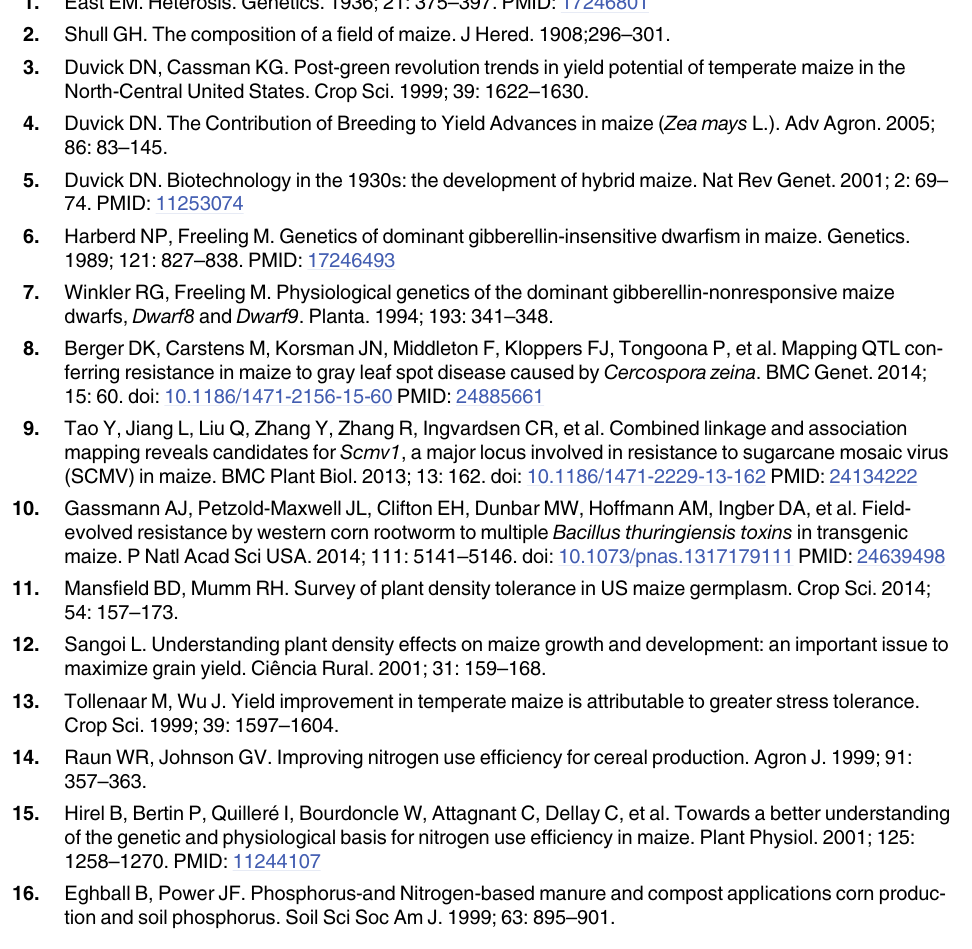
S2 Table. The genotyping information of intermated B73 × Mo17 (IBM) recombinant in- bred lines (RILs) used for genetic likage group construction. "A" and "B" represent the geno- type of B73 and Mo17 respectively, and "-" represents the missing genotype. "S1_10096204" represents the single nucleotide polymorphism (SNP) occurred in the position 10096204 on Chromosome 1 of B73 reference genome (V2). The naming format is applicable for other SNPs. S3 Table. The homozygous proportion of intermated B73 × Mo17 (IBM) individuals and heterozygosity of TC(B) and TC(M)